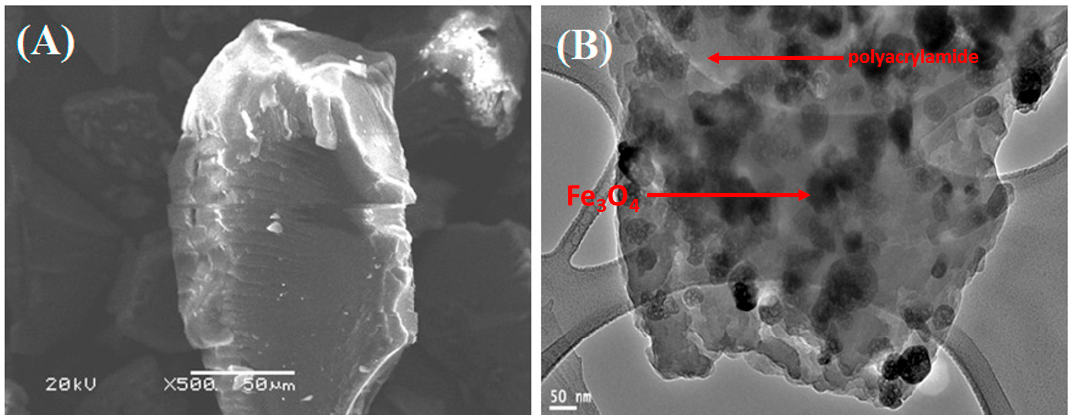
Figure 4. SEM ( A ) and TEM ( B ) images of polyacrylamide-functionalized magnetite, showing a dense anti-corrosive surface and uniform distribution of magnetite nanoparticles in the polyacrylamide capping moiety [11].